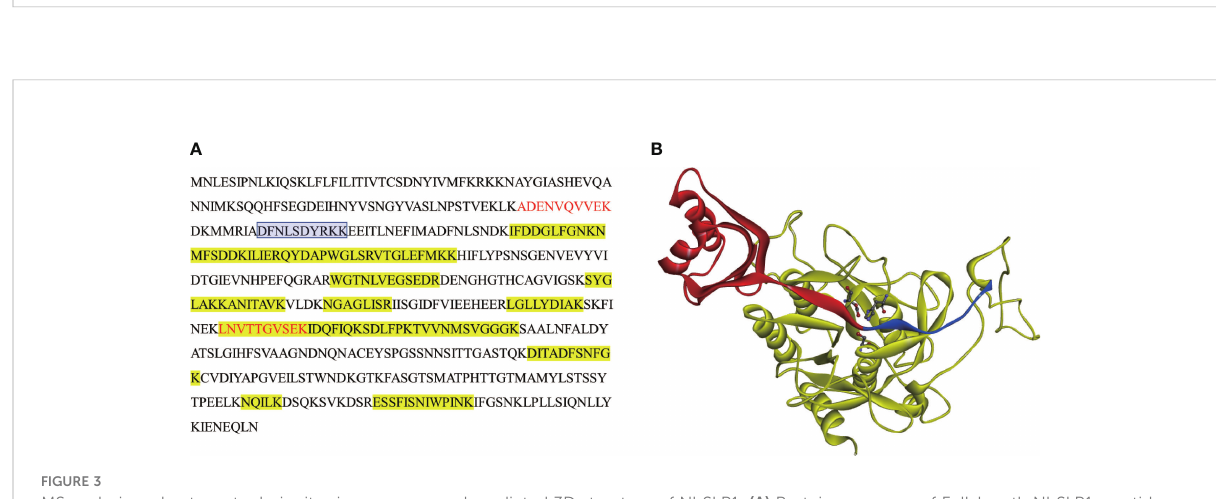
FIGURE 3 MS analysis and autoproteolysis sites in sequence and predicted 3D structure of NbSLP1. (A) Protein sequence of Full-length NbSLP1, peptides of ~14 kDa (band in Figure 2A indicated by blue arrow) detected by MS are showed in red font, peptides of ~45 kDa (band in Figure 2A indicated by red arrow) highlighted in yellow, N-terminus sequence of mature NbSLP1 is showed in blue frame; (B) Predicted 3D structure of NbSLP1. Pro-peptide is showed in red ribbon; mature NbSLP1 is showed in yellow ribbon; autoproteolysis site is showed between red and blue ribbon; NbSLP1 catalytic triad Asp 192 -His 224 -Ser 413 is showed in ball and stick